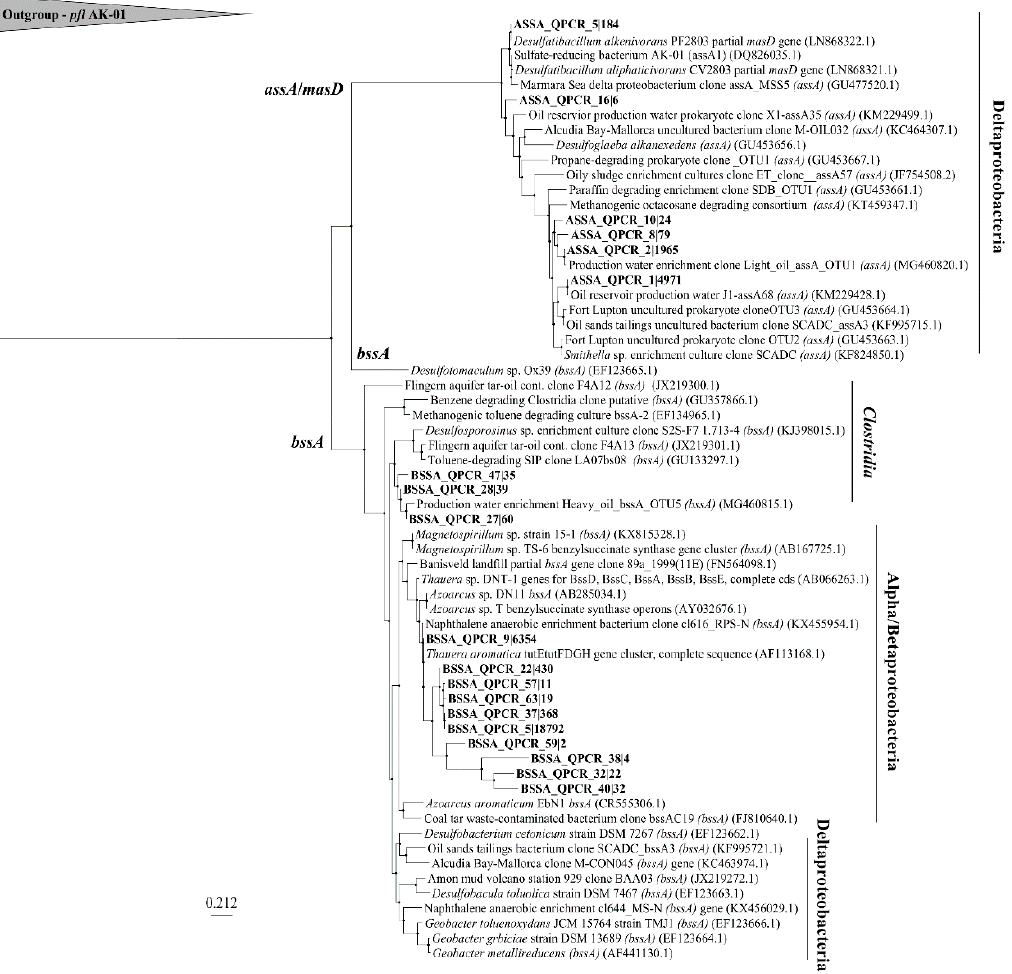
Figure 6. Maximum likelihood phylogram of sequenced assA and bssA amplicons. Nucleic acid sequences were aligned with ClustalX (30 iterations). Tree-building via PhyML 3.0 Maximum Likelihood using TN93 substitution model, fast likelihood-based method aLRT (approximate likelihood ratio test) for branch supporting, and SPR (subtree pruning and re-grafting) tree improvement model. The outgroup is pyruvate formate lyase (pfl) from sulfate-reducing strain D. alkenivorans strain AK-01.